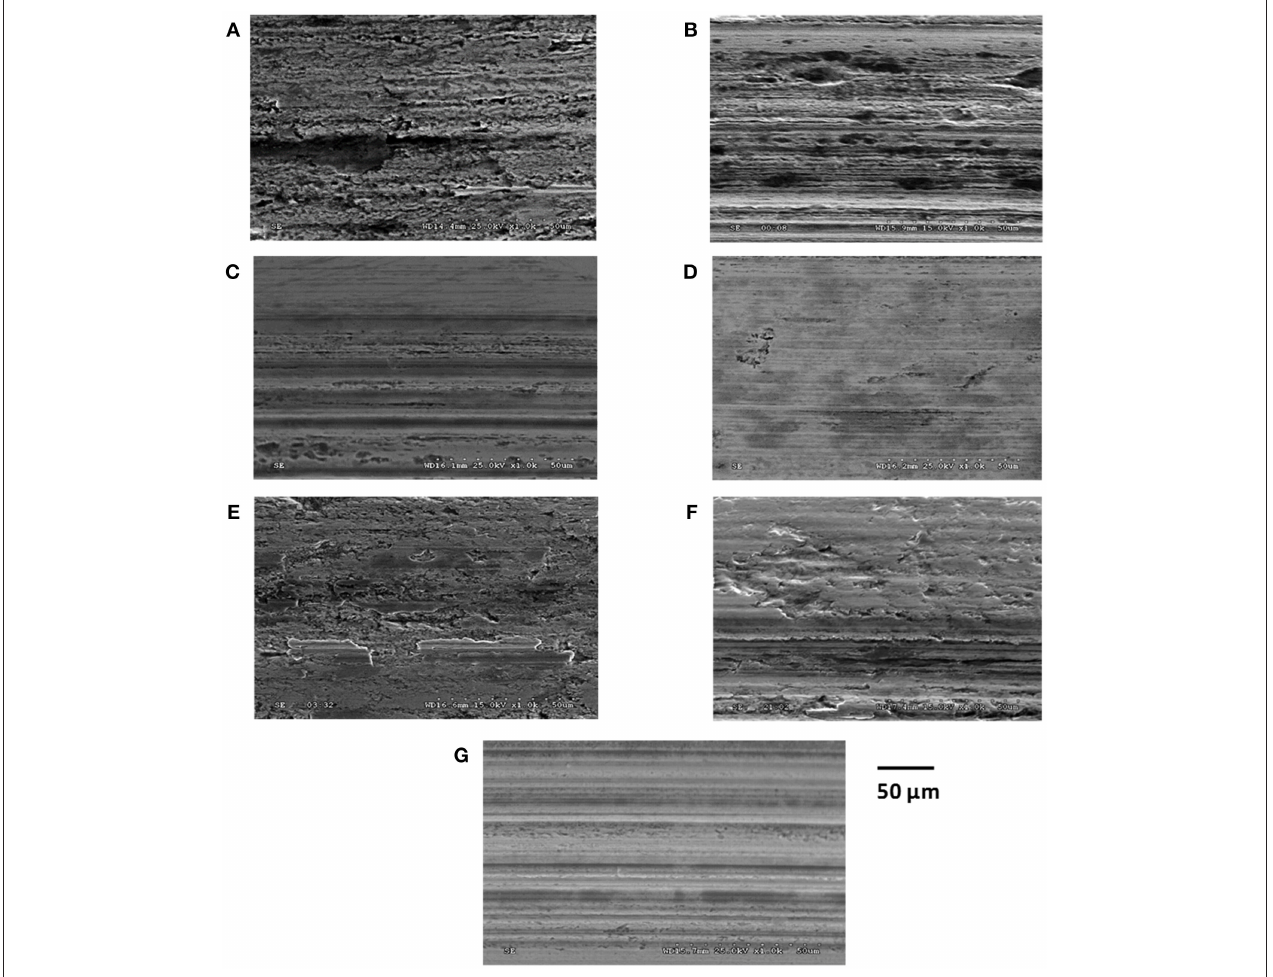
FIGURE 4 | Secondary electron microscopy images at 1,000X magnification of the wear scars from four ball wear tests for grease blends. (A) Base grease (B) MWCNT (C) P IL1 (D) P IL2 (E) N IL1 (F) N IL2 (G)